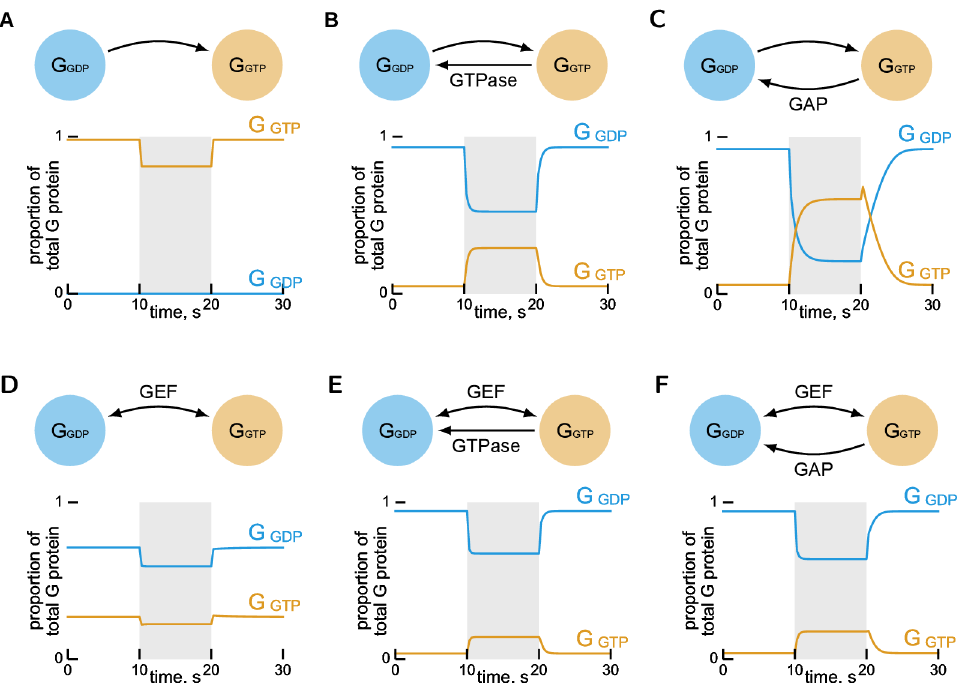
Fig 2. Apparent activation of G proteins via GEFs is only observed when GTPase activity is present. Simulation of mass-action models, see Methods. G GXP denotes GXP-bound G protein. The shaded region denotes stimulation of the system by increasing the active GEF 10-fold from its basal concentration. For all simulations, steady-state concentrations were used as the initial conditions. Mass corresponding to GEF (cid:1) G protein complexes has not been drawn. A, B, C An artificial irreversible model, constructed by assuming the rate of release of GTP from the active GEF (cid:1) G protein complex is zero. D, E, F The reversible GEF mechanism (Fig